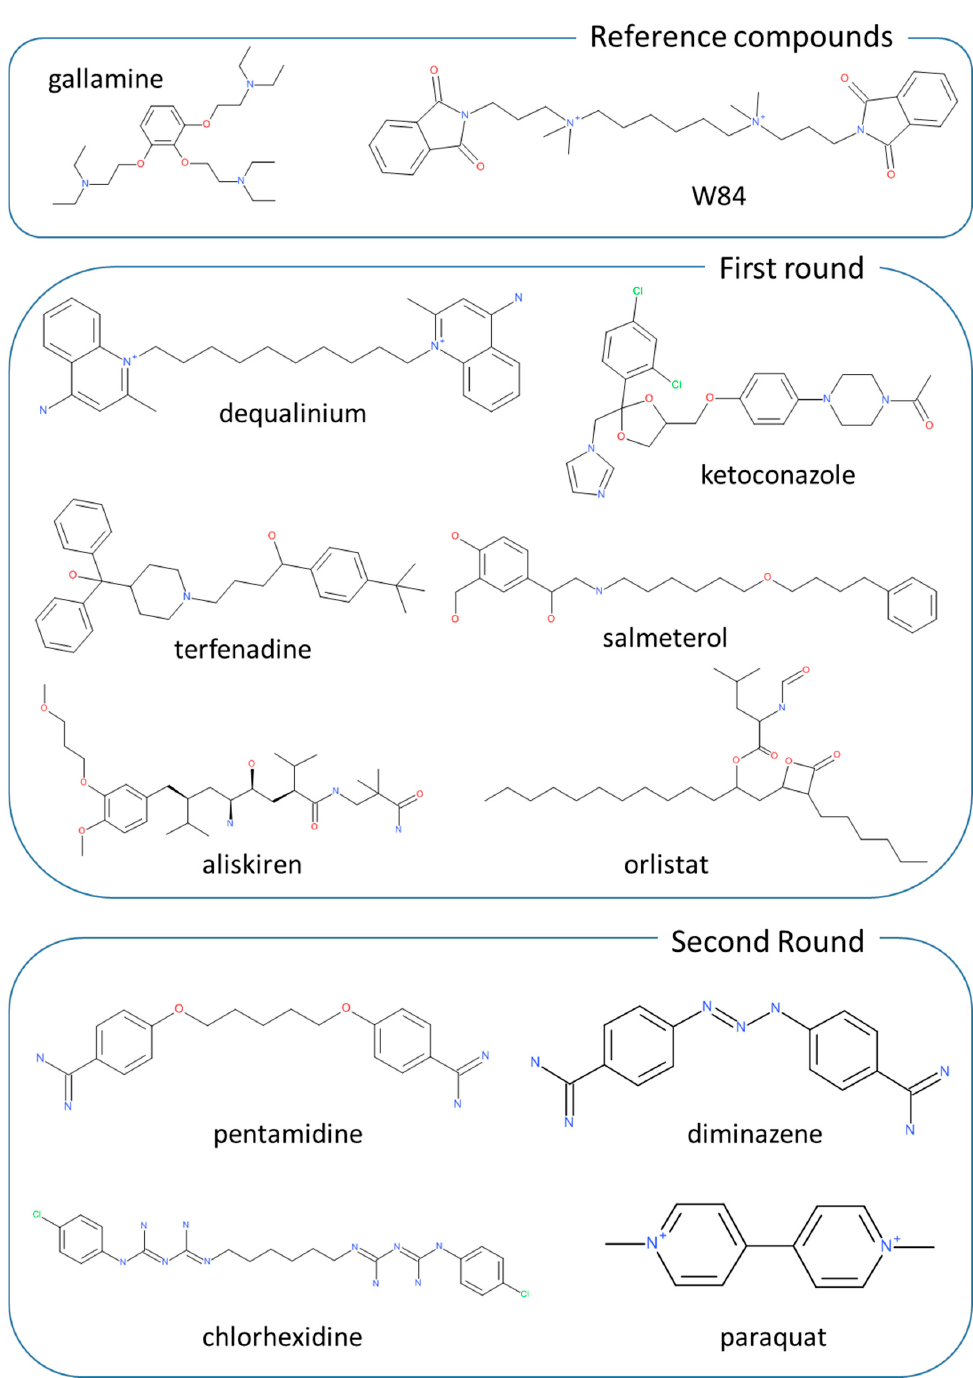
Figure 1. Chemical structures of the retrieved hits from virtual screening (VS) campaigns which were experimentally investigated by binding assays. The chemical structures of the two reference compounds (namely, gallamine and W84) were also